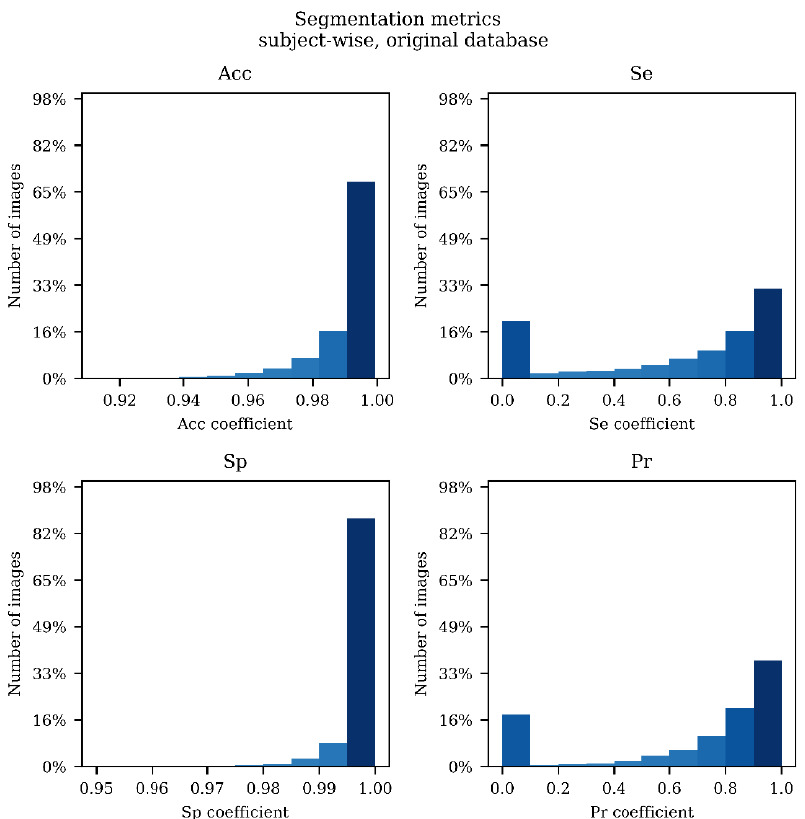
Figure A6. Histograms of metrics for segmentation results on a test set for a network trained on the original database with 5 -fold subject-wise cross-validation. Acc — accuracy; Se — sensitivity; Sp — specificity; Pr — precision.